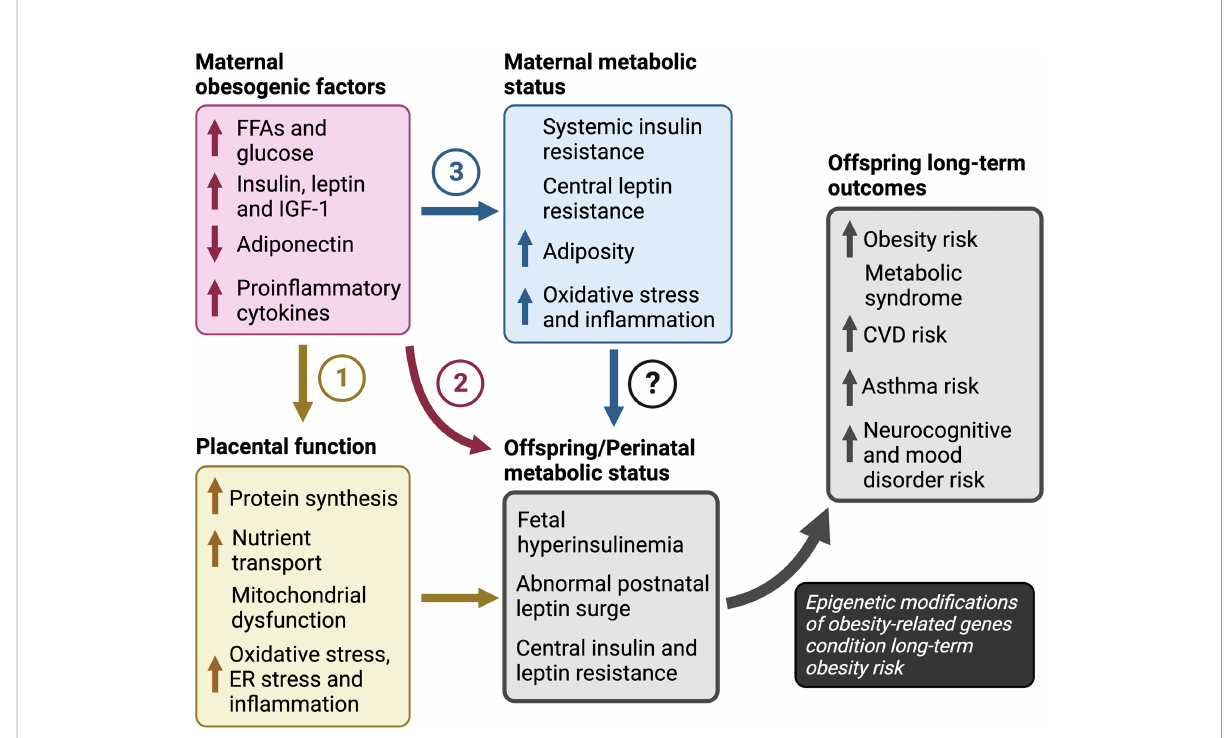
FIGURE 3 Pathways to obesity in children in response to maternal overnutrition The pathways of maternal obesogenic factors towards long-term obesity risk include: (1) dysregulation of placental function in which excess nutrients promote placental protein synthesis, mitochondrial dysfunction and increased nutrient transport, (2) increased nutrient availability, that may have a direct effect on fetal growth and development independent of changes in placental function, and (3) altered maternal sensitivity to hormones leptin and insulin. However, the roles of maternal insulin and leptin resistance, independent of maternal hyper-insulinemia or -leptinemia, are unclear and further investigation is required to determine their impact on the perinatal metabolic transition to life and outcomes in offspring. Finally, we propose that increased risk for obesity, metabolic syndrome, and atherosclerotic cardiovascular disease, depends on an abnormal metabolic status during the perinatal period in response to maternal factors. CVD; cardiovascular disease, ER; endoplasmic reticulum, FFAs; free fatty acids, IGF-1; insulin-like growth